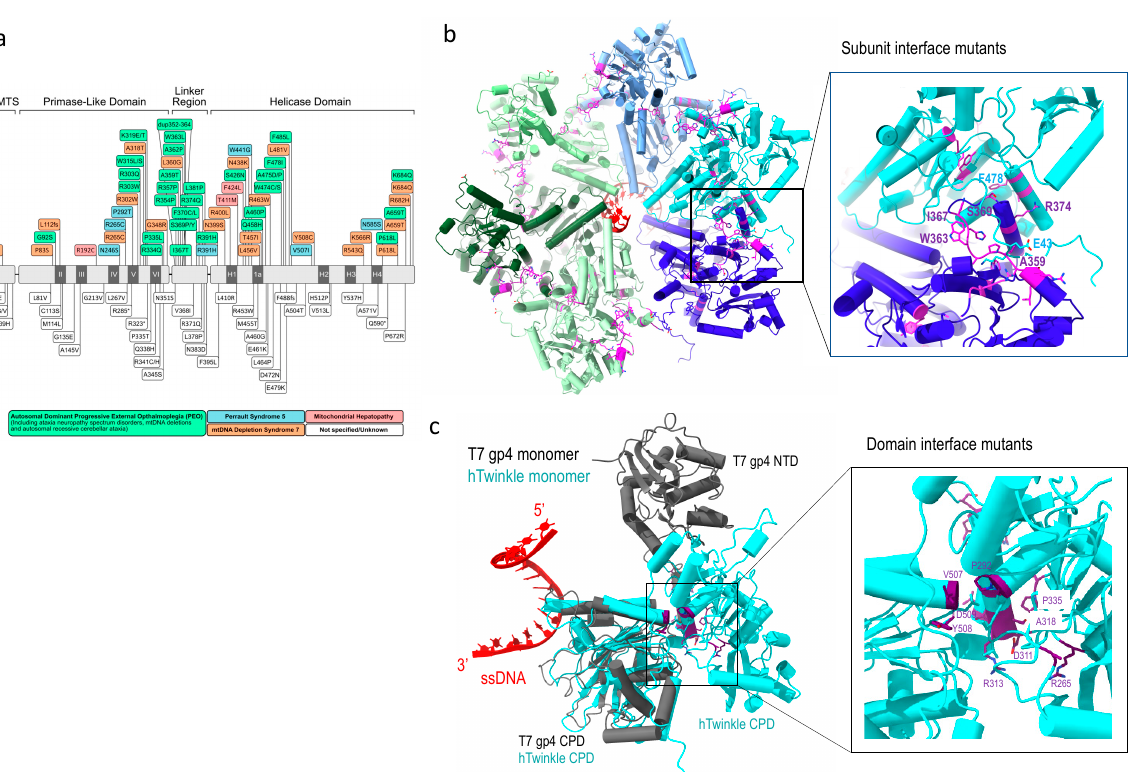
Figure 5. Twinkle disease-implicated mutations. ( a ) Linear depiction of Twinkle mutations implicated in human diseases, adopted from [10], ( b ) subunit interface mutations (magenta), and ( c ) domain interface mutations (purple), where Twinkle subunit is colored in cyan, T7 gp4 in grey, and single-stranded DNA in red.